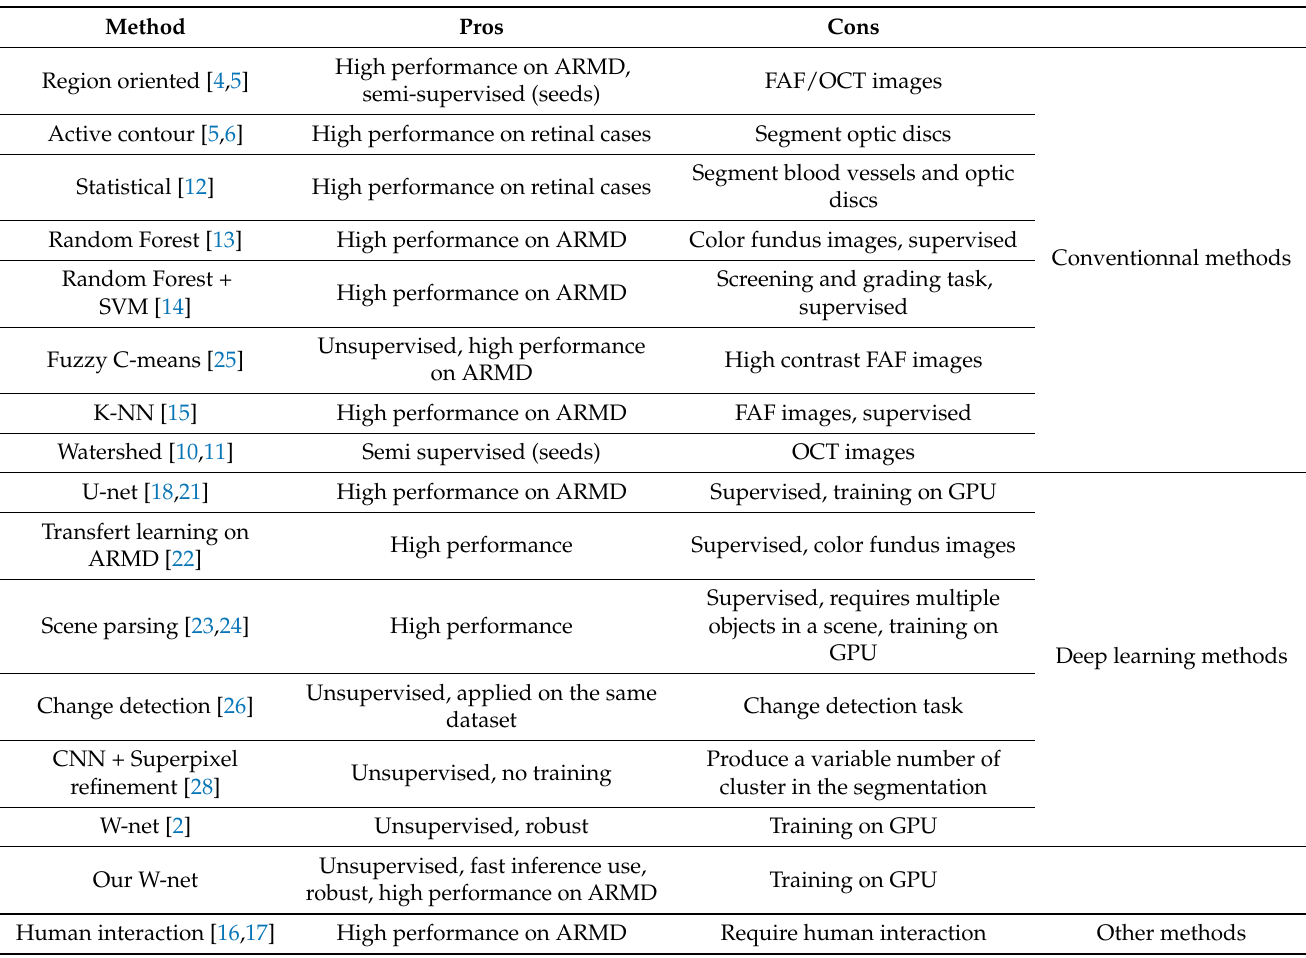
Table 1. Comparative summary of related